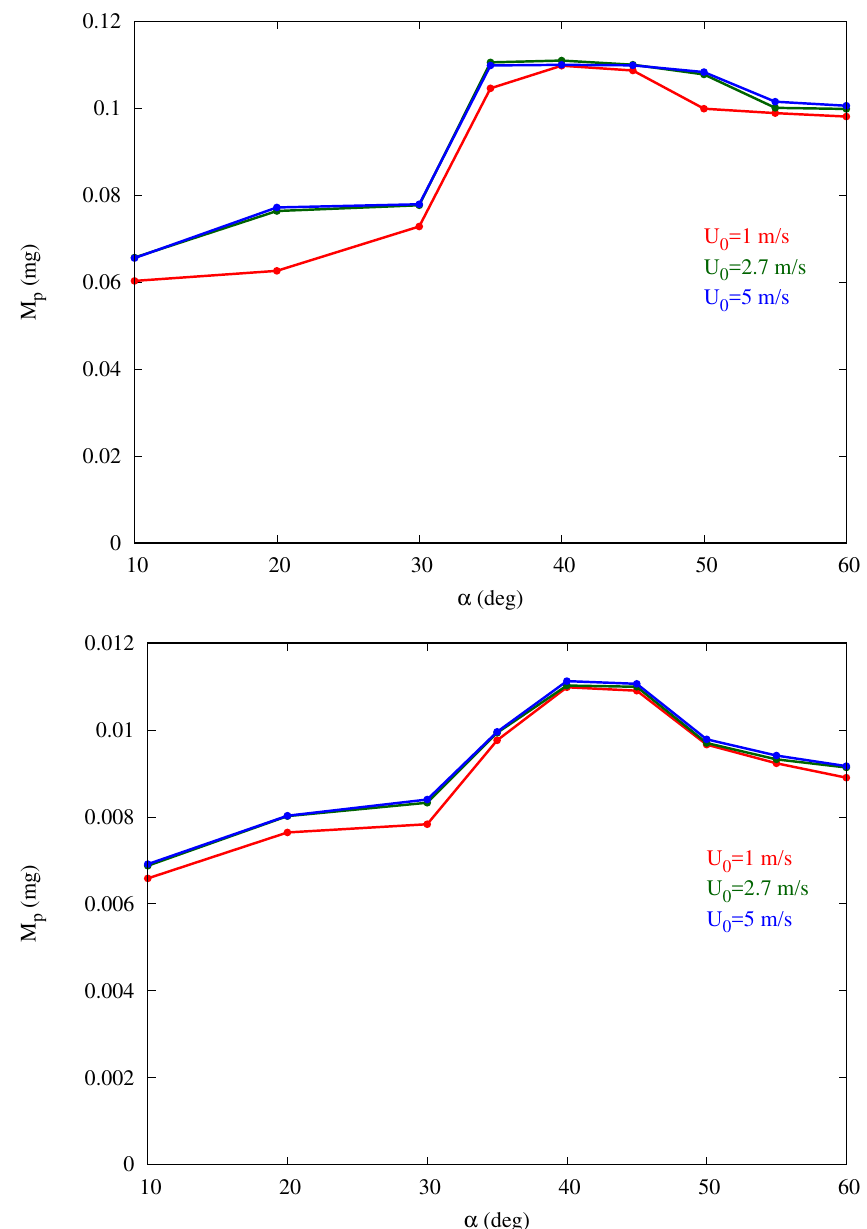
Figure 6. Water mass collected (as droplets) on the ellipsoidal surface vs. body inclination angle α for three different free-stream velocities U 0 . The two panels correspond to different droplet volume fraction in the slab, f p , and hence different water mass M 0 injected in the computational domain. Top panel: f p = 3.6 × 10 − 3 and M 0 = 1.44mg (runs A2–A10, B2–B10, C2–C10 in Table 1); Bottom panel: f p = 3.6 × 10 − 4 and M 0 = 0.144mg (runs D2–D10, E2–E10, F2–F10 in Table